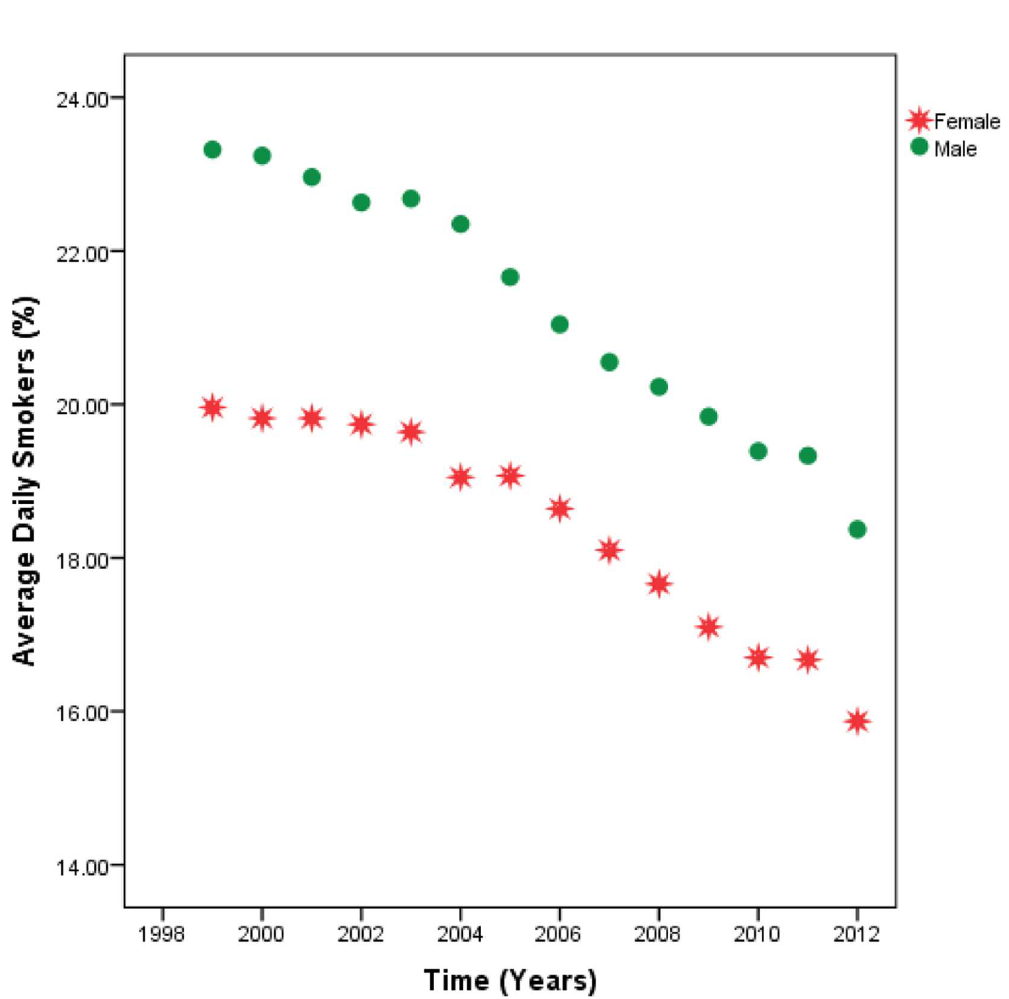
Fig 3. Estimates of mean percentage of daily smokers by gender across all U.S. geographic regions,